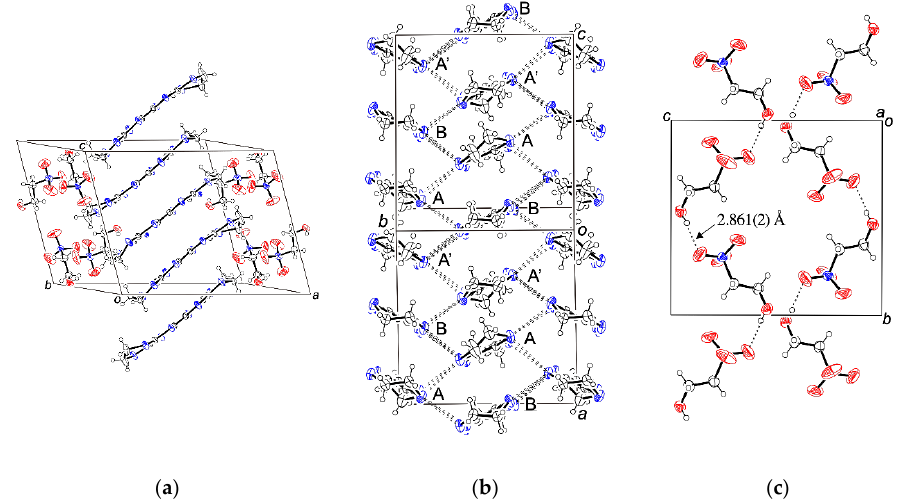
Figure 1. Crystal structure ( a ); arrangement of the donor layer ( b ), where dashed lines indicate short S···S contacts (<3.7 Å ); and structure of the anionic layer ( c ) of 1 .